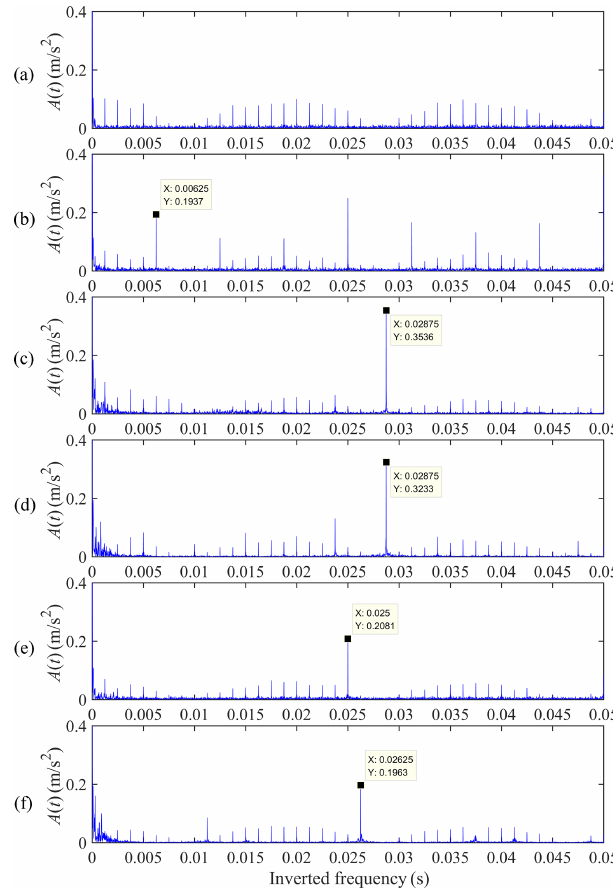
Figure 9. Cepstrum of synthetic vibration signals: (a) healthy gear case, (b) failure case I, (c) failure case II, (d) failure case III, (e) fail- ure case IV, and (f) failure case